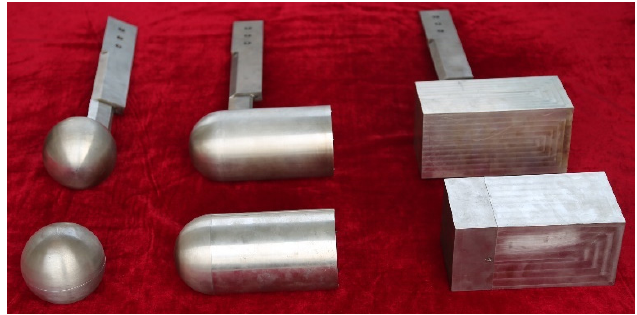
Figure 7. Models used in experiment on flows around debris in near space.